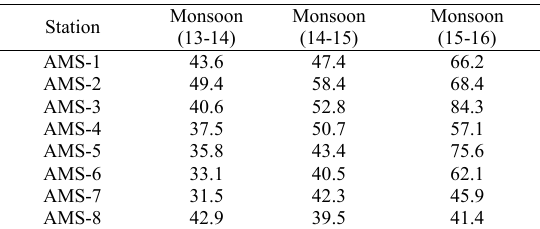
Table 6: AQI of different station bases on monsoon season